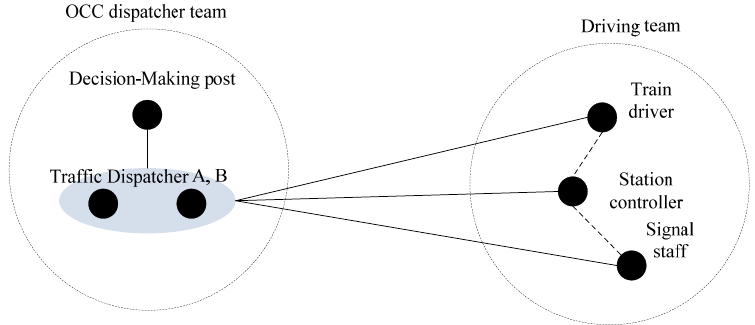
Figure 4. The coordination structures model for the traffic dispatching team task.